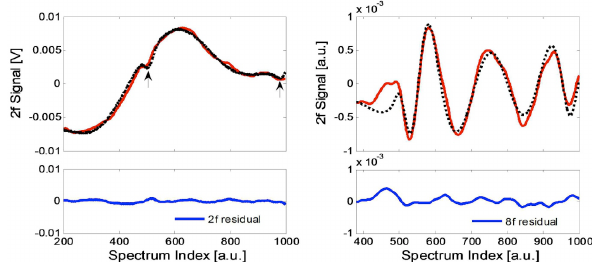
Fig. 3. Ammonia 2f (left) and ethylene 8f (right) spectra recorded at 10 Hz with real-time fitting results (dotted lines) and residuals. The 2f NH 3 signal was recorded for ambient laboratory conditions of 19.0ppbv NH 3 . The two arrows in the 2f plot denote the locations of the two extra troughs due to the ethylene reference signal.